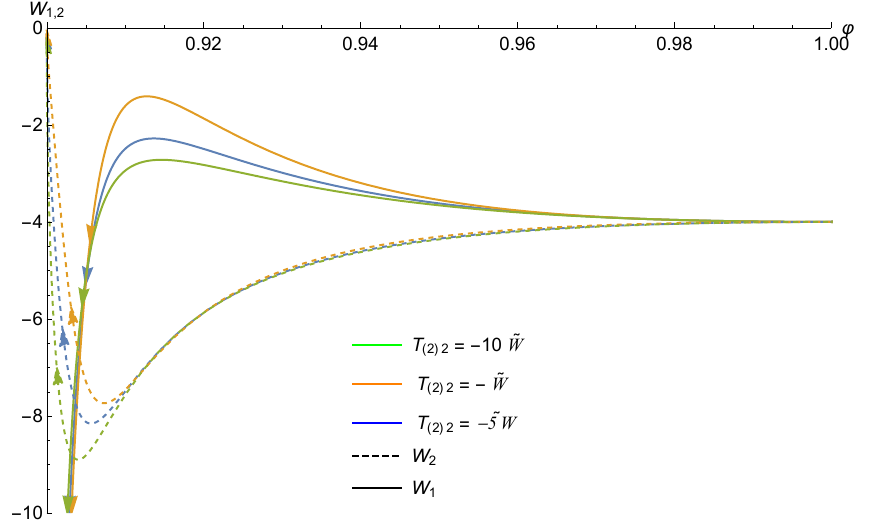
Figure 14 . Plot of the superpotentials W 1 , W 2 as functions of ϕ for different choices of α , for Bolt end-point solutions. The IR endpoint for this plot has been chosen to be at ϕ of the flow is indicated in the figure: it starts from the UV fixed point and ends at the IR. The different lines correspond to different choices of the integration constant T defined in